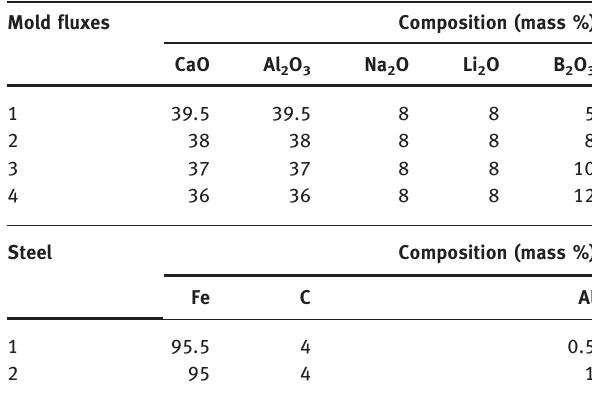
Table 1: Initial compositions of mold fluxes and steel for present